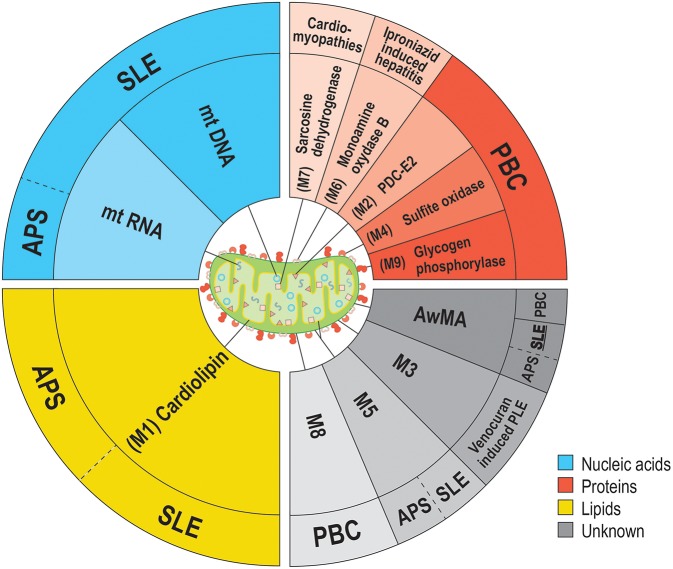
Anti-mitochondrial antibodies and related diseases. Several types of anti-mitochondrial antibodies (AMA) have been reported in various diseases. The epitopes targeted by AMA cover all families of biomolecules: lipids (yellow background), proteins (red hues) or nucleic acids (blue hues). However, the precise nature of some mitochondrial epitopes targeted by AMA are still unclear. (gray hues). To date, the sole mitochondrion-specific phospholipid antigen reported in both APS and SLE is cardiolipin (M1). M1 is located within the mitochondrial inner membrane (MIM) in healthy organelles, but may be displayed on the outer membrane (MOM) upon damages to the organelle. Distinct AMA against an unknown antigen (M5) were also reported in both APS and SLE. Four antigens are associated with PBC; PDC-E2 (M2, MIM), sulfite oxidase (M4, MOM), M8 (MOM), and glycogen phosphorylase (M9, MOM). These mitochondrial antigens are peptidic, with the exception of M8, whose nature remains uncharacterized. Sarcosine dehydrogenase (M7) is another immunogenic protein that is targeted by autoantibodies in patients suffering from cardiac conditions (i.e., hypertrophic or idiopathic cardiomyopathies or acute myocarditis). Two types of AMA were reported as iatrogenically induced in human patients: AMA-M3 (unknown, MOM) and AMA-M6 (monoamine oxidase B, MOM). In addition to these autoantibodies, we have reported the presence of autoantibodies targeting whole mitochondria (AwMA) in patients with SLE, APS, and PBC (with higher titers found in SLE donors). Moreover, antibodies specific to the mtDNA were specific to SLE patients. In the present study, we describe autoantibodies against mtRNA in patients with SLE and APS.